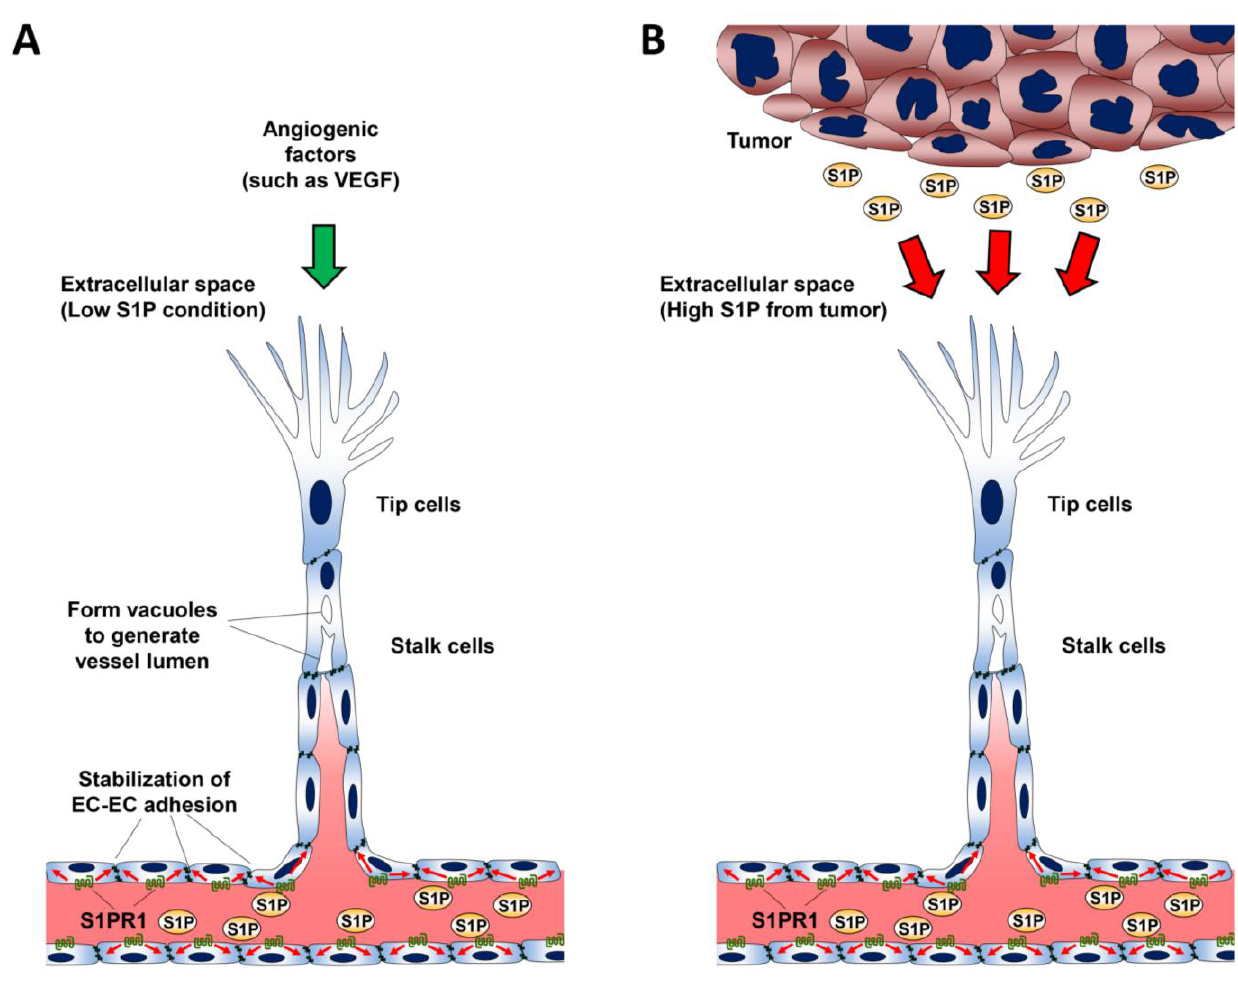
Figure 2. S1P and sprouting angiogenesis in normal development and in tumor-induced